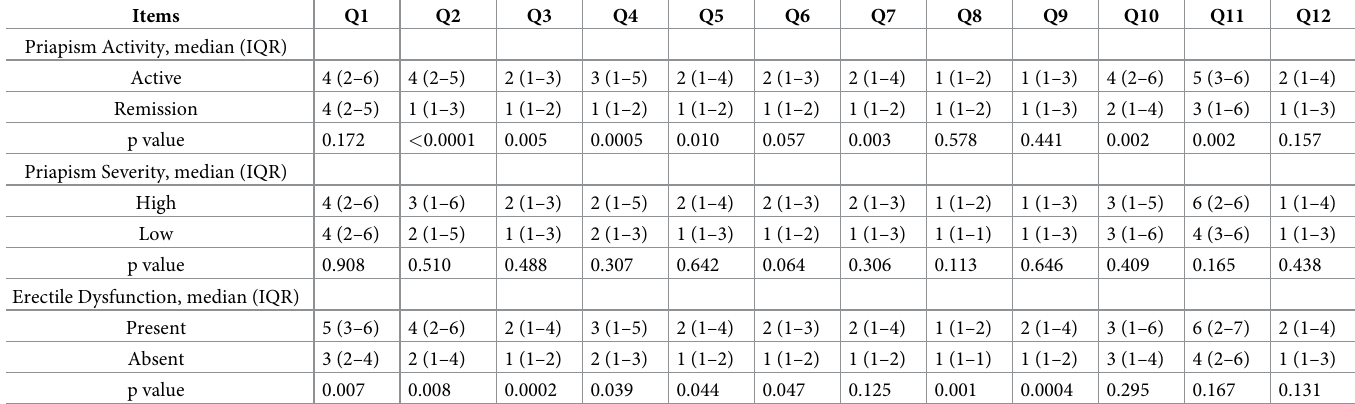
Table 3. PIP questionnaire criterion-oriented validity of questions 1–12 based on comparison of patient subgroups.